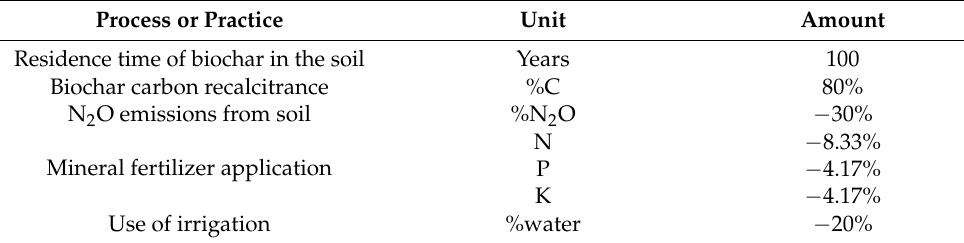
Table 4. Effects and parameters used to explore potential biochar soil effects and biochar stability. Process or Practice